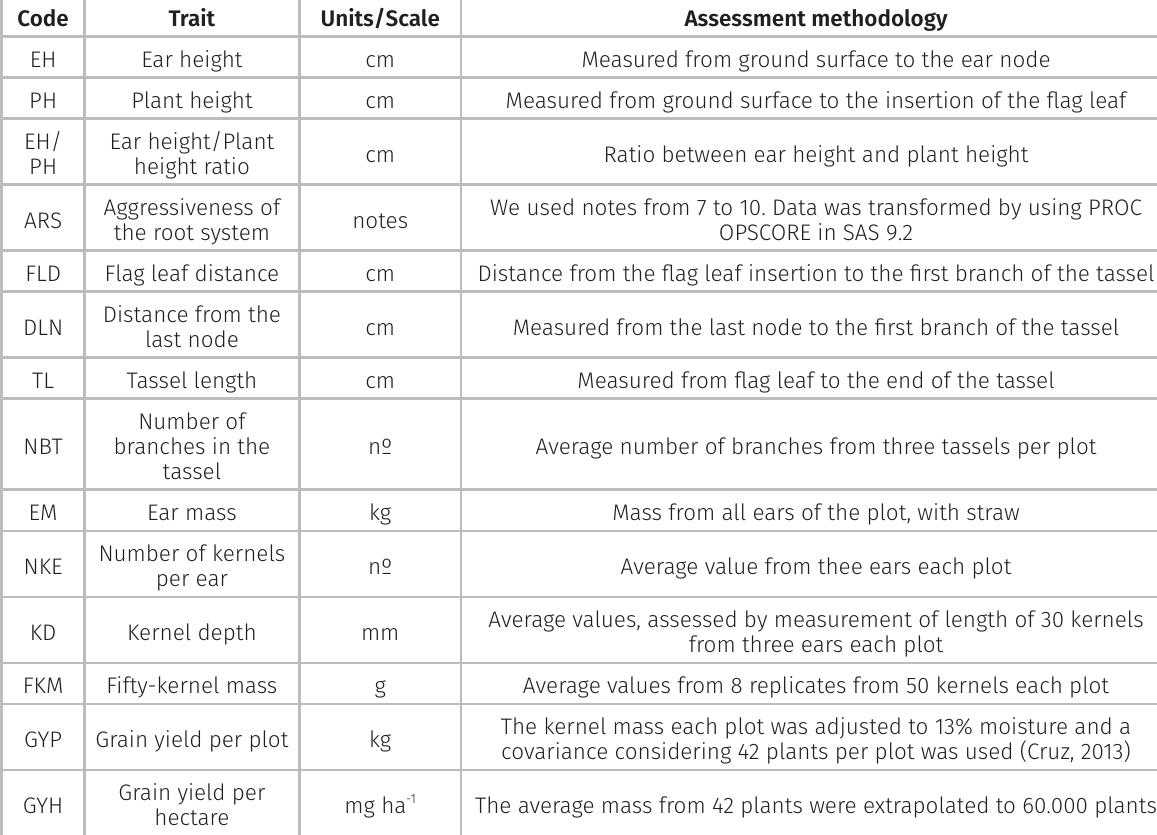
Table I. Description and methodology of assessment of the 14 traits evaluated in 90 simple maize